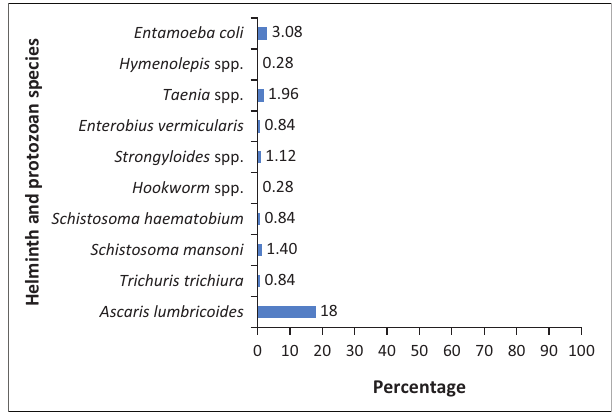
FIGURE 1: Helminth and Entamoeba coli prevalence by species in the study population ( n = 357 †